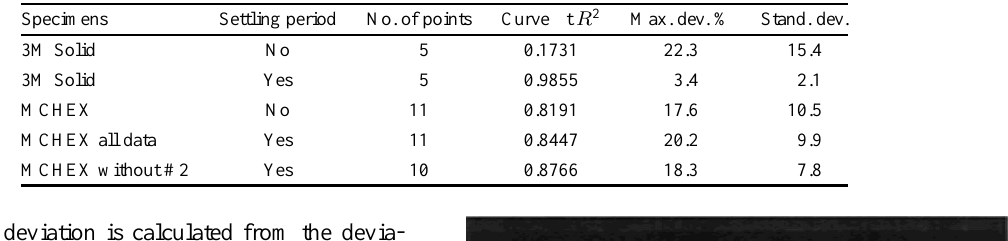
Data curve fit (strain = aN b ) statistics